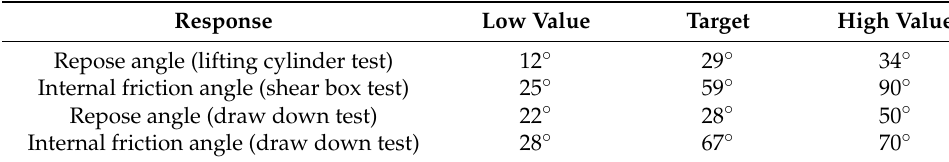
Table 5. Definition of targets to response optimization.